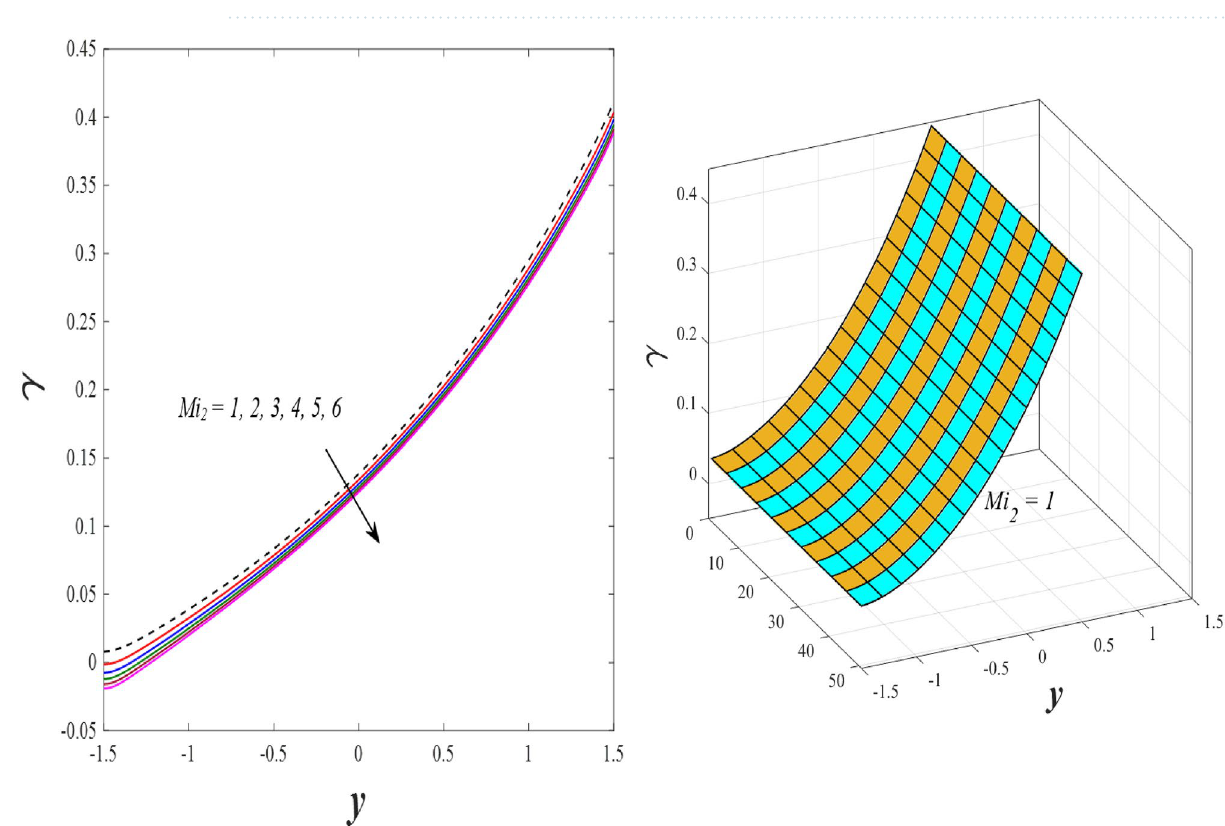
Figure 22. Effect of mass Biot number Mi 2 on the distribution of solutal